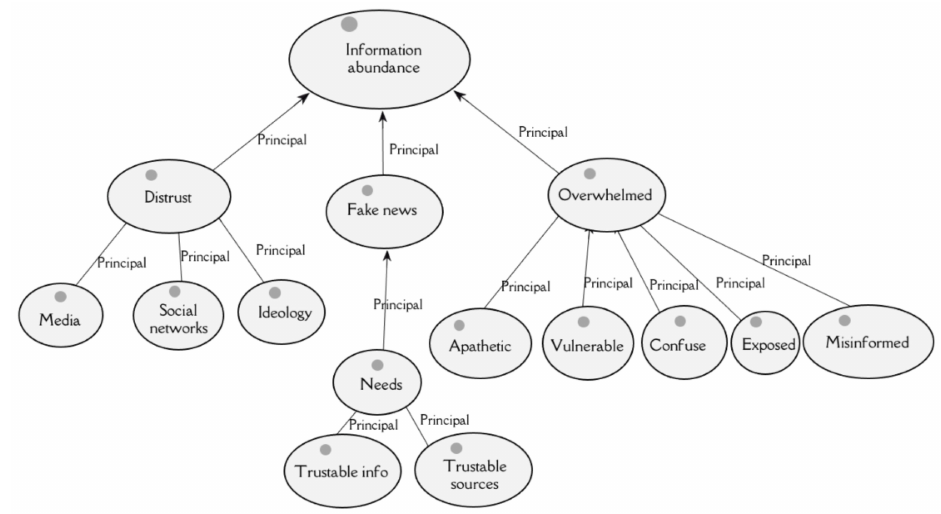
Figure 6. Conceptual map of categories. Own